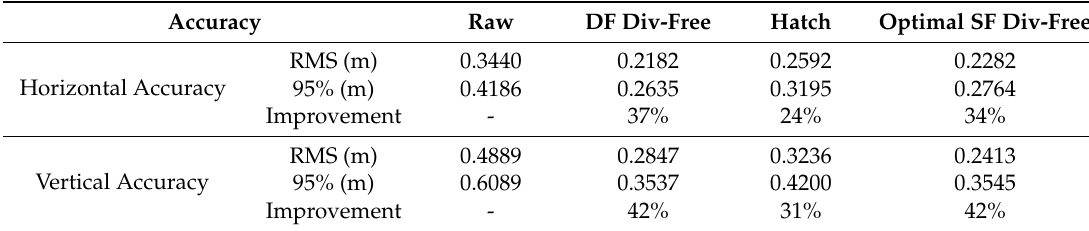
Figure 14. Position accuracy (RMS) improvement by local time. Table 4. Statistics of the position error during daytime (12:00–18:00).